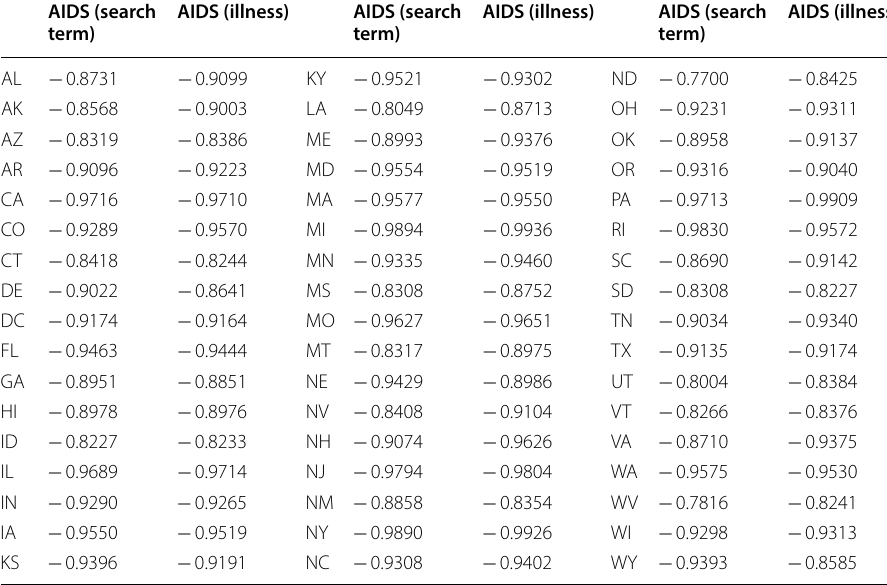
All correlations reported in this table are statistically significant with p < 0.01